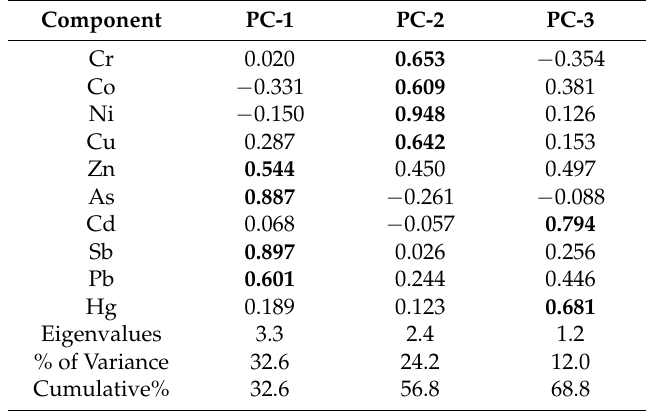
Table 6. Varimax rotated principal components analysis of metal(loid)s in Hezhang city ( n = 30). Component PC-1